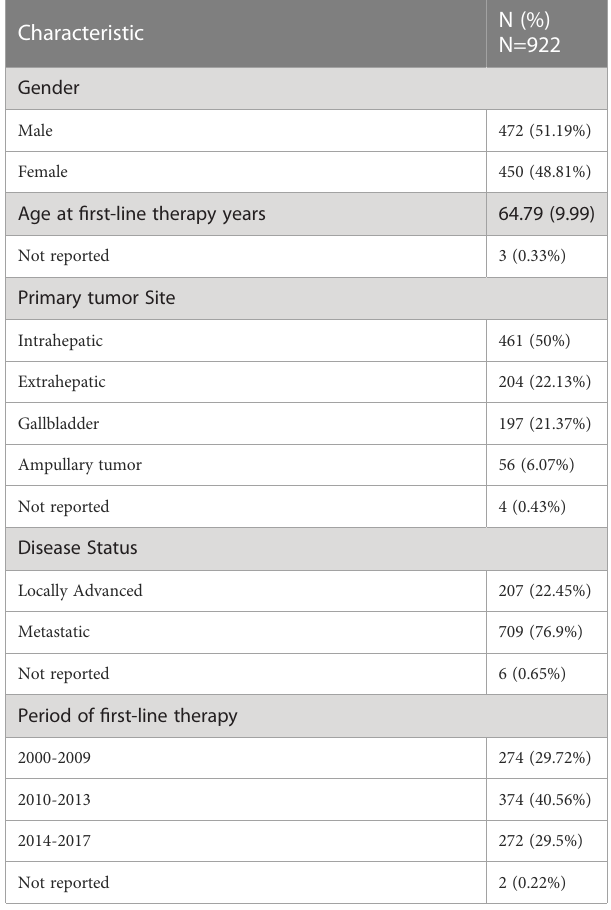
TABLE 1 Demographic and clinical characteristics of study participants at